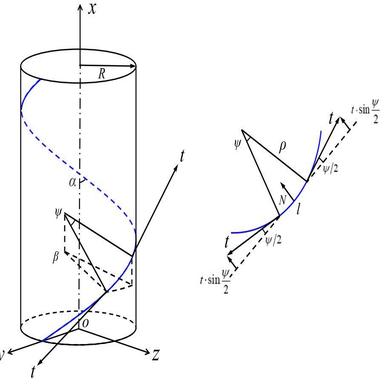
Fiber centripetal force model.